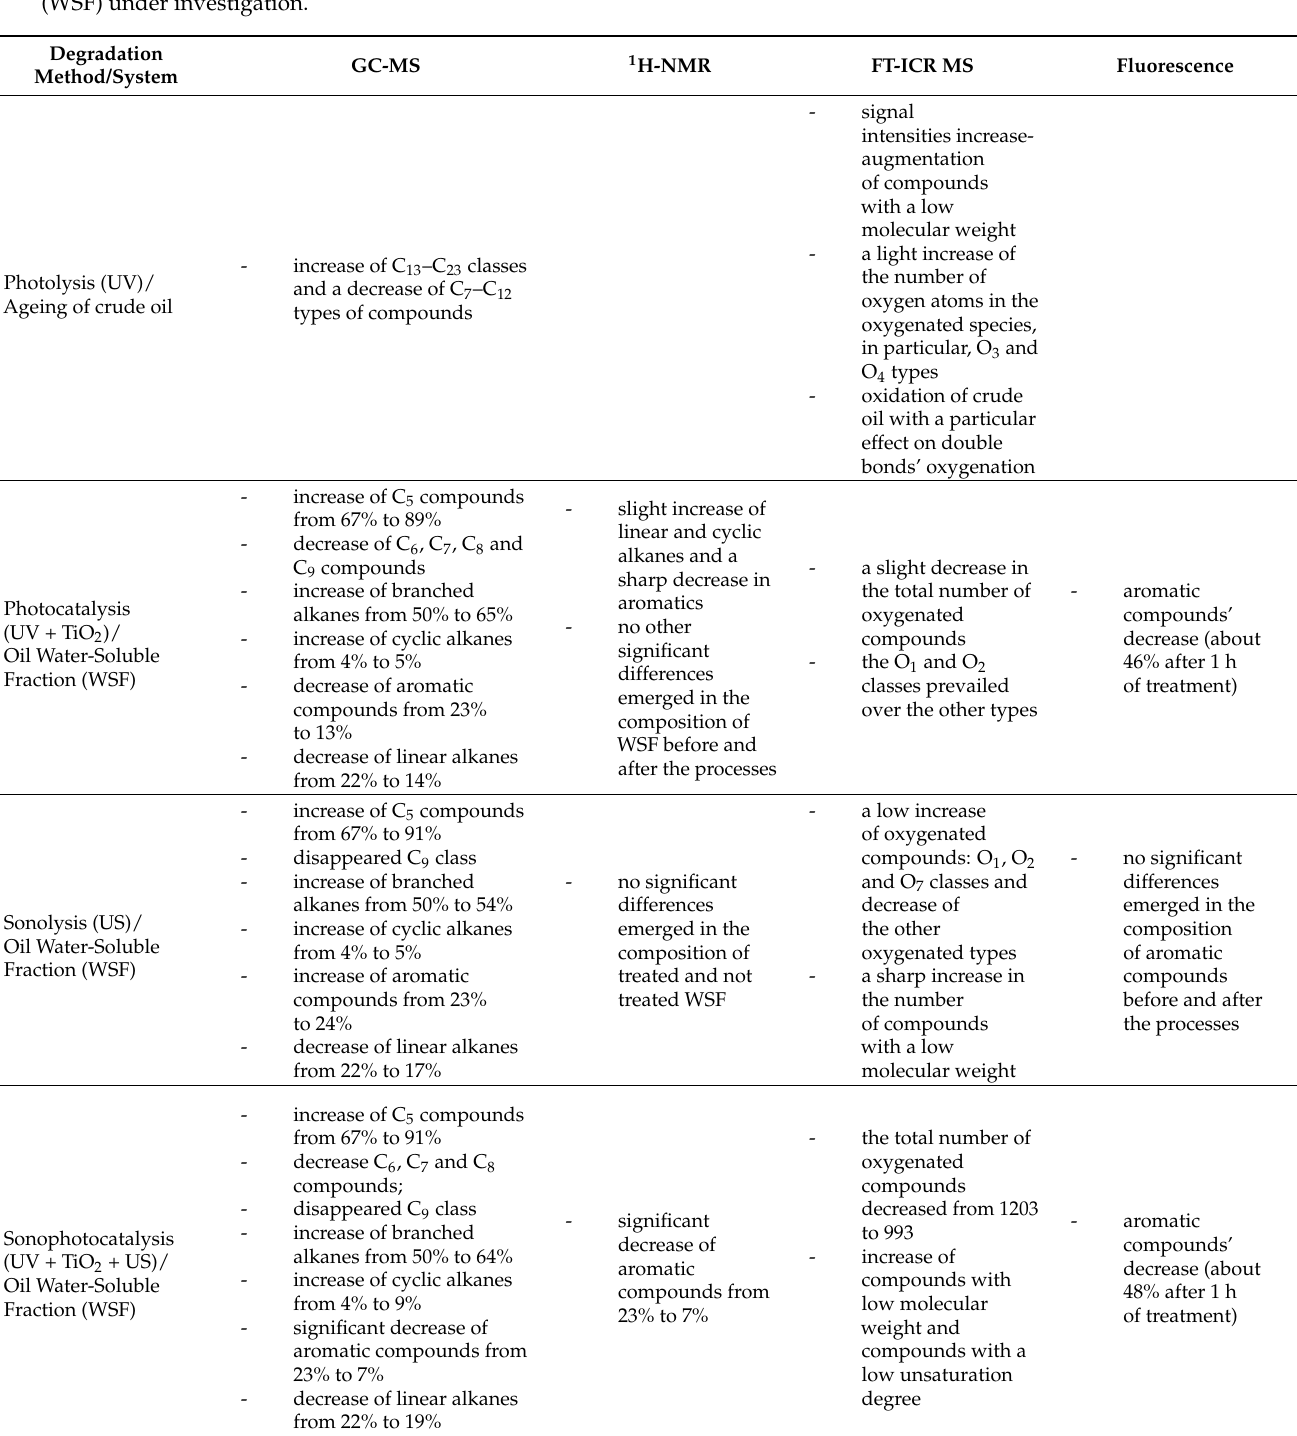
Table 2. Synthetic results obtained from the different photodegradation processes of crude oil and oil water-soluble fraction (WSF) under